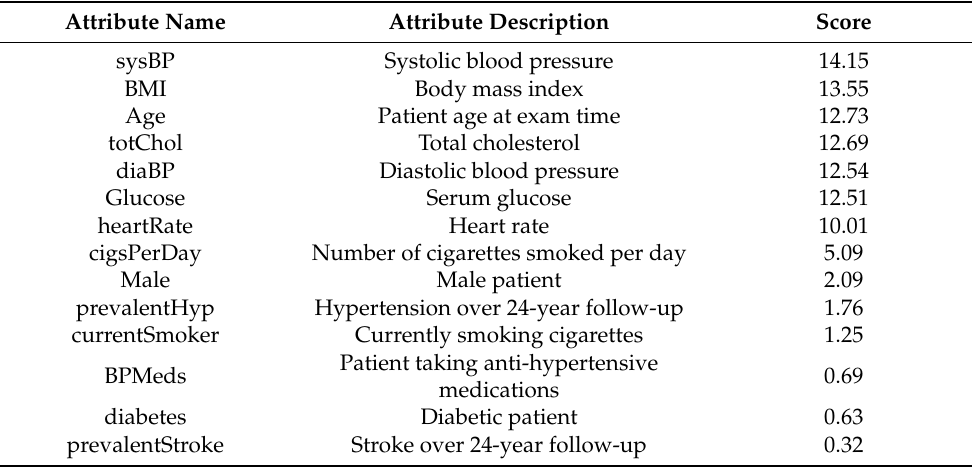
Table 5. Selected attributes from the Framingham dataset with Random Forest.